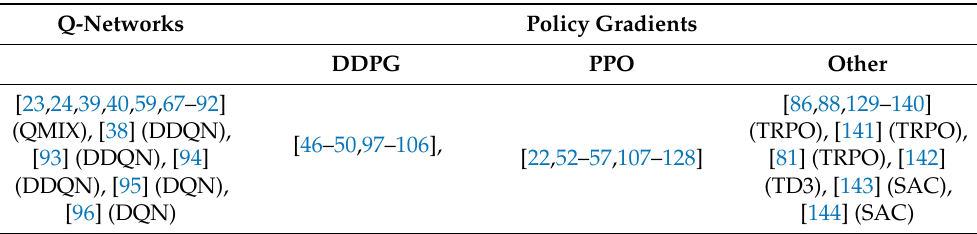
Table 1. Types of deep RL algorithms used in the surveyed papers are listed. If a popular algorithm is used as a foundation, the algorithm’s name is also mentioned within